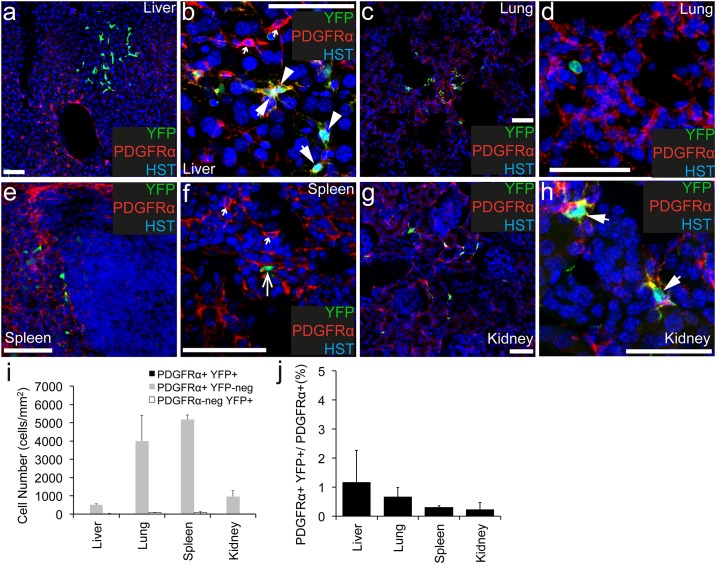
PDGFRα+ cells recombine at low efficiency in the liver, lung, spleen and kidney.Cryosections from P57+7 Pdgfrα-CreERT2::Rosa26-YFP transgenic mice were immunostained to detect PDGFRα (red), YFP (green) and HST (blue). Confocal image (single z plane) of the liver at low (a) and high (b) magnification. Confocal image (single z plane) of the lung at low (c) and high (d) magnification. Confocal image (single z plane) of the spleen at low (e) and high (f) magnification. Confocal image (single z plane) of the kidney at low (g) and high (h) magnification. (i) The number of PDGFRα+ YFP+, PDGFRα+ YFP-negative and PDGFRα-negative YFP+ cells quantified from confocal images (single z plane) of the liver, lung, spleen and kidney expressed as the number of cells per mm2. (j) The proportion of PDGFRα+ cells that become YFP-labelled (PDGFRα+ YFP+ cells/ total PDGFRα+ cells, expressed as a percentage) quantified from confocal images (single z plane) of the liver, lung, spleen and kidney. Error bars represent mean ± std dev from n = 3 mice. PDGFRα+ YFP+ cells are denoted by arrowheads. PDGFRα-negative YFP+ cells are denoted by arrows. PDGFRα+ YFP-negative cells are denoted by small arrows. Scale bars represent 50μm